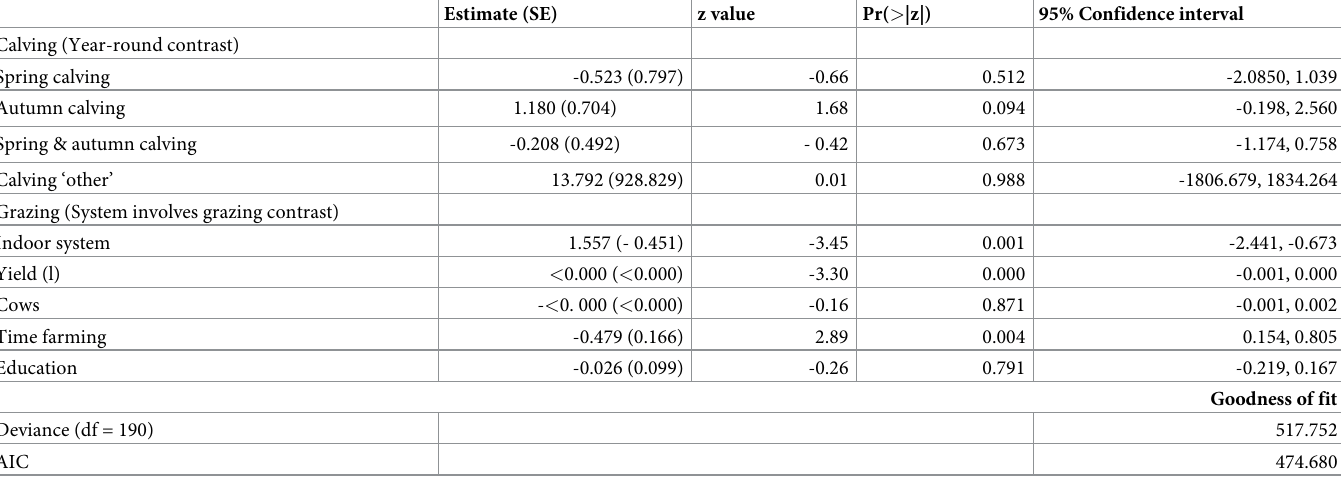
Table 3. ‘Cows should have access to pasture for at least part of the year’–ordinal model summary results. Estimate (SE) z value Pr( > |z|) 95% Confidence